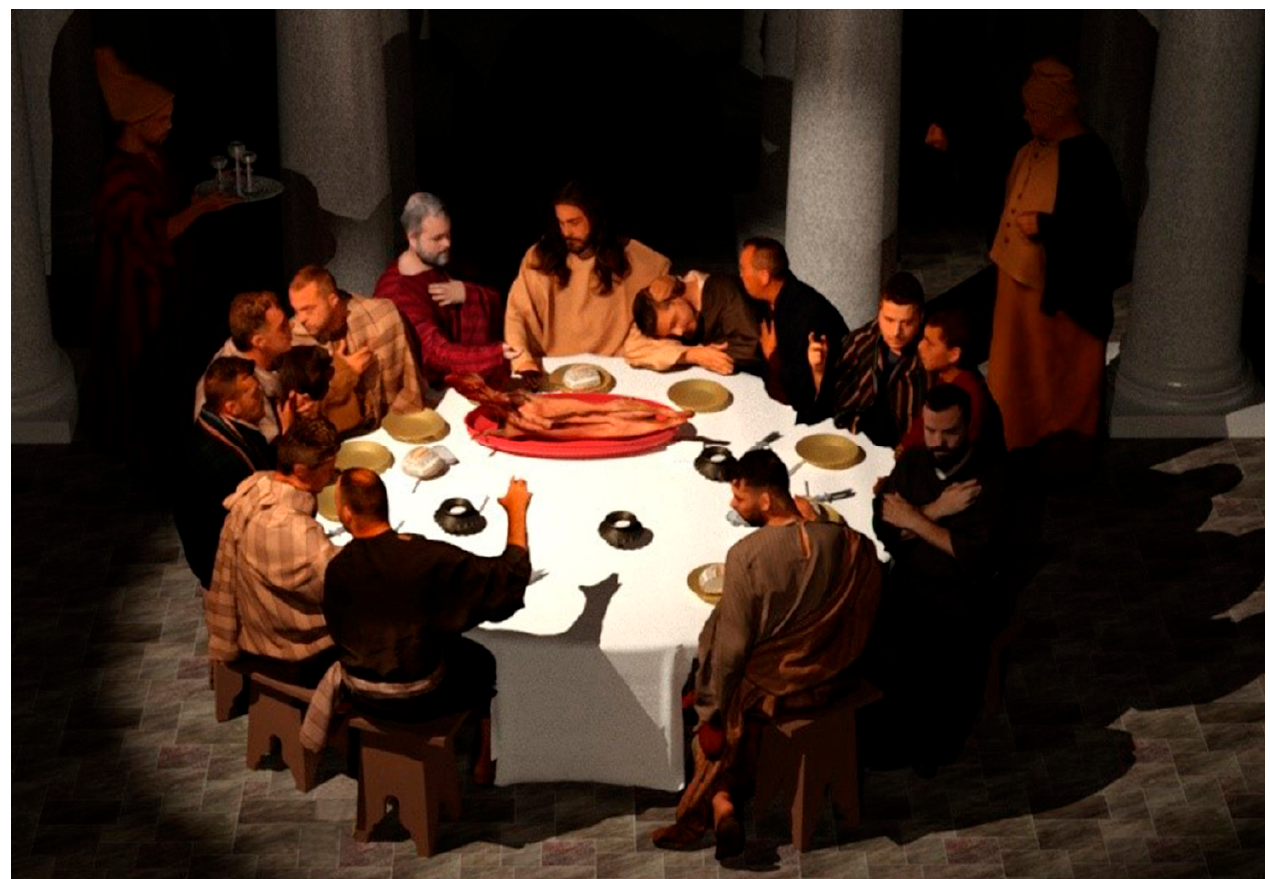
Figure 11. View of the table with the textured characters.